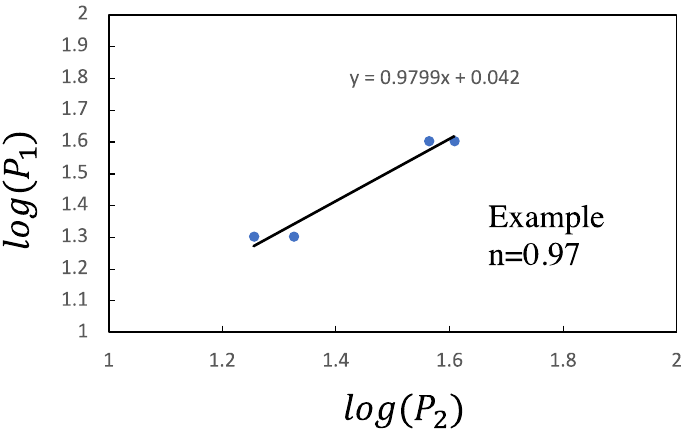
Figure 5. Example of measured data and exponent of the power function.